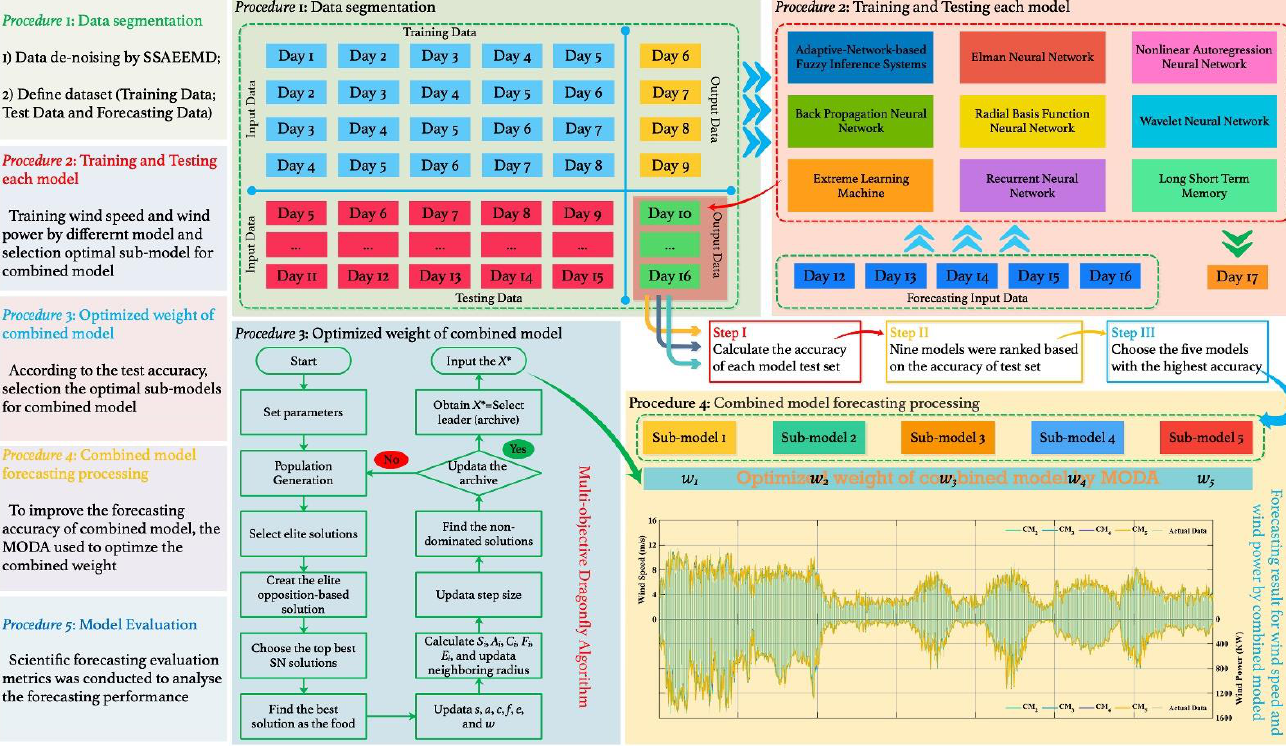
Figure 1. Flow Chart of the Proposed Model.